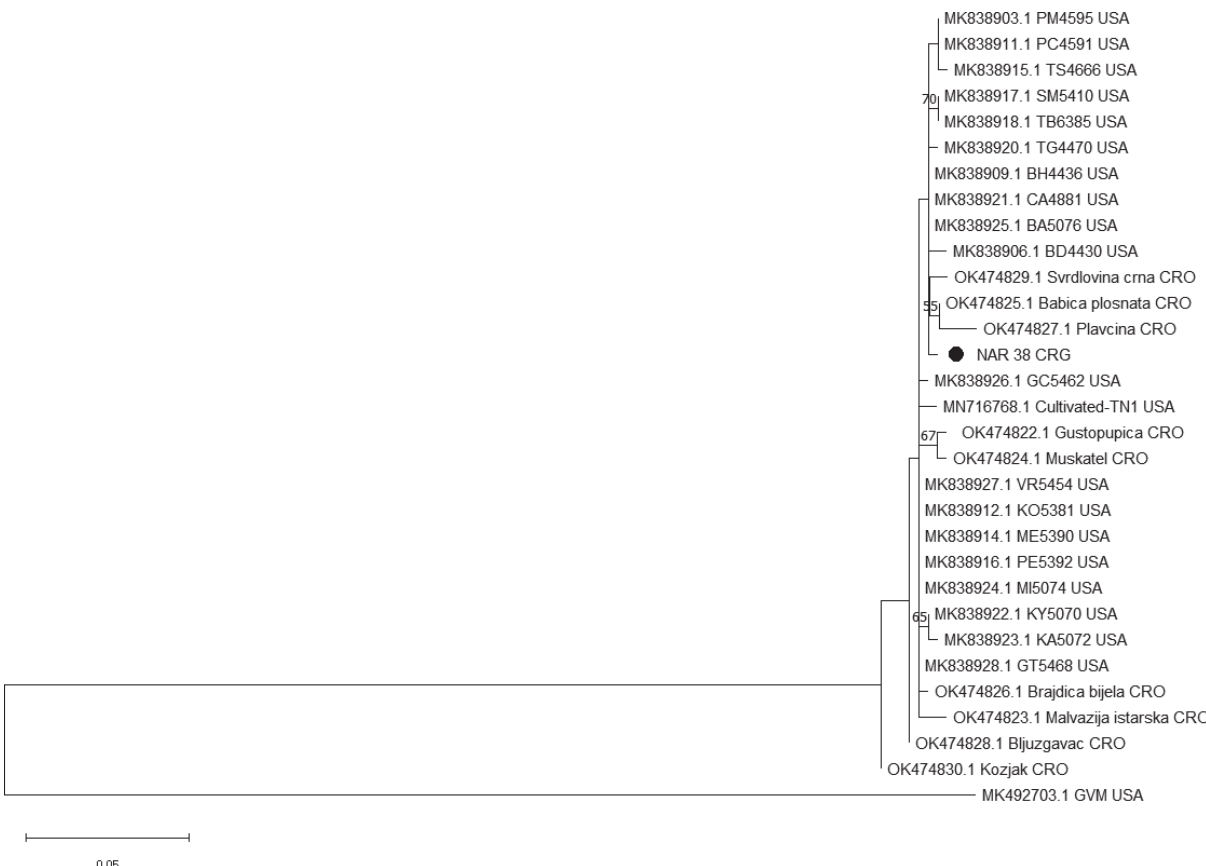
Figure 2. Phylogenetic tree generated from partial nucleotide sequences of the GVH CP region. Bootstrap values were obtained using 1000 replicates. Only branches having a support greater than 50% are indicated. The Sardinian isolate detected in this study is indicated by a black dot. The phylogenetic tree was reconstructed using the maximum likelihood algorithm implemented in the MEGA X software. Nine- teen isolates from different countries located in the collection in the United States of America (USA) and eight isolates from Croatia (CRO) were selected from GenBank and used to construct the tree. The GVM sequence (MK492703) was used as the rooting